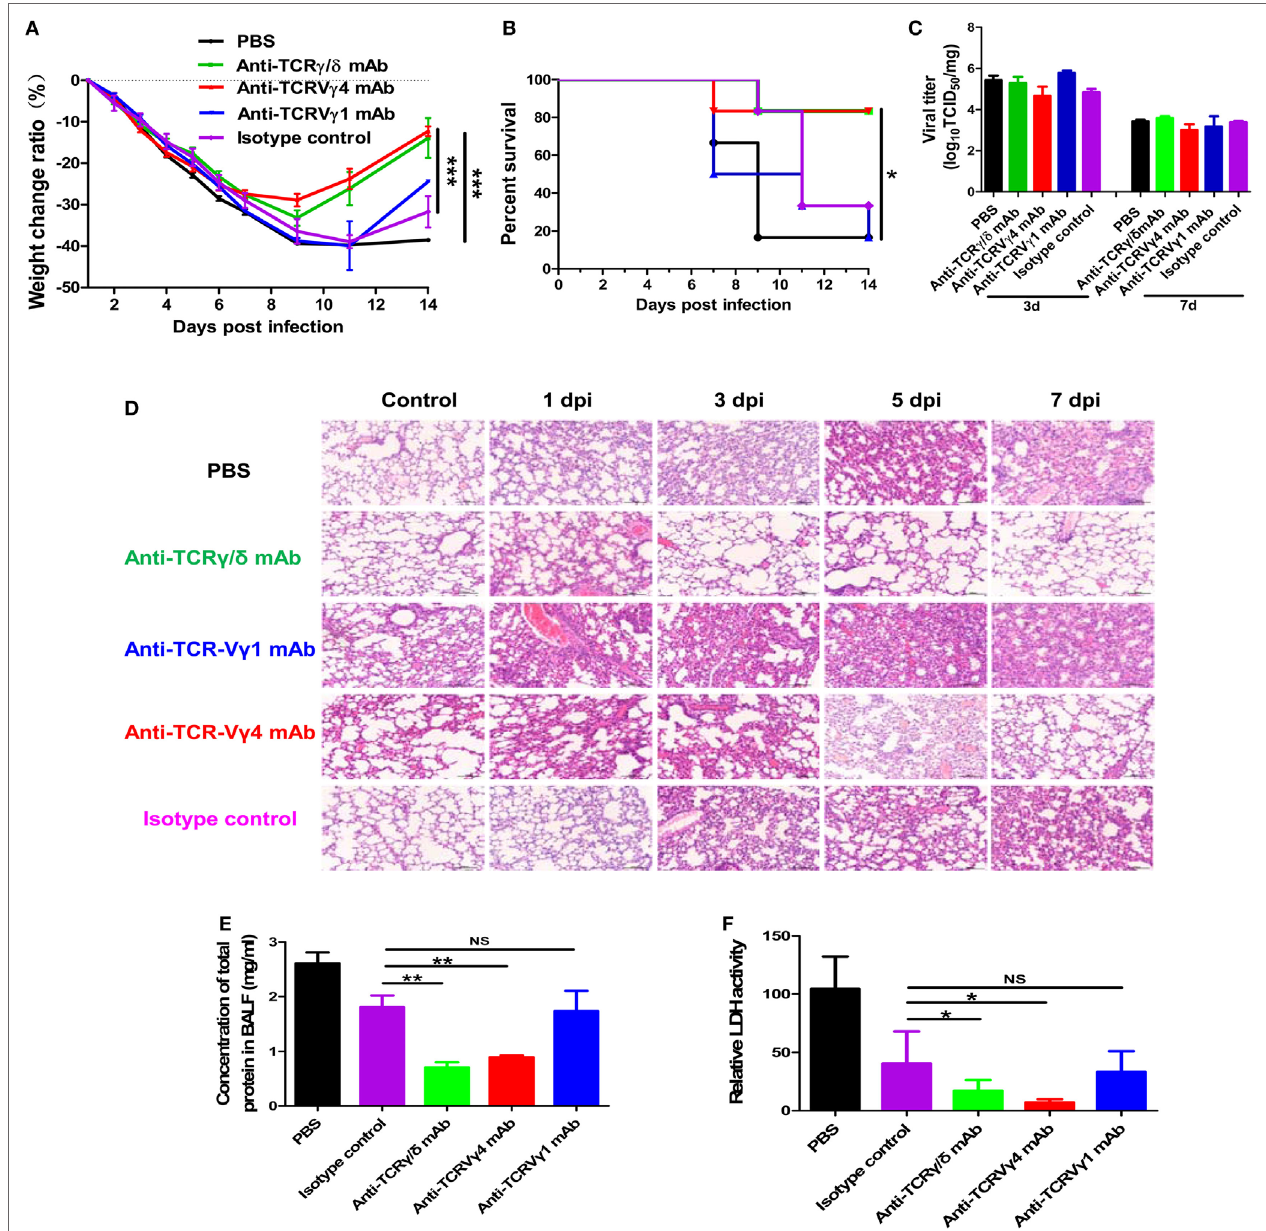
FigUre 8 | Depletion of γδ T cells or the V γ 4 + γδ T subset reduced inflammatory damage and improved the survival rate. Weight change (a) and survival rate (B) of the PBS or isotype control group, γδ T cell depletion group, V γ 1 + γδ T cell depletion group, and V γ 4 + γδ T cell depletion group after intranasal inoculation with influenza A (H1N1) pdm09 virus ( n = 6 for each group). (c) Viral titer in the lungs of different cell depletion groups determined at 3 and 7 dpi. (D) Representative hematoxylin and eosin staining of lung sections from the control group and the γδ T, V γ 1 + γδ T, and V γ 4 + γδ T cell depletion groups at the indicated dpi. Original magnification: × 200. Total protein concentration (e) and relative LDH activity (F) in BALF from the control group and different cell depletion groups at 3 dpi. * p < 0.05, ** p < 0.01, *** p <